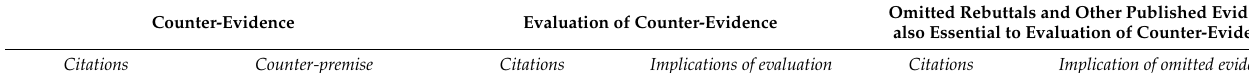
Table 5. Hagmann et al.’s ([3] Table 5) about severity of historical fires is replicated in the left two columns, with omitted published evidence added in the right column, to show Hagmann et al. omitted published evidence and made incorrect conclusions as a